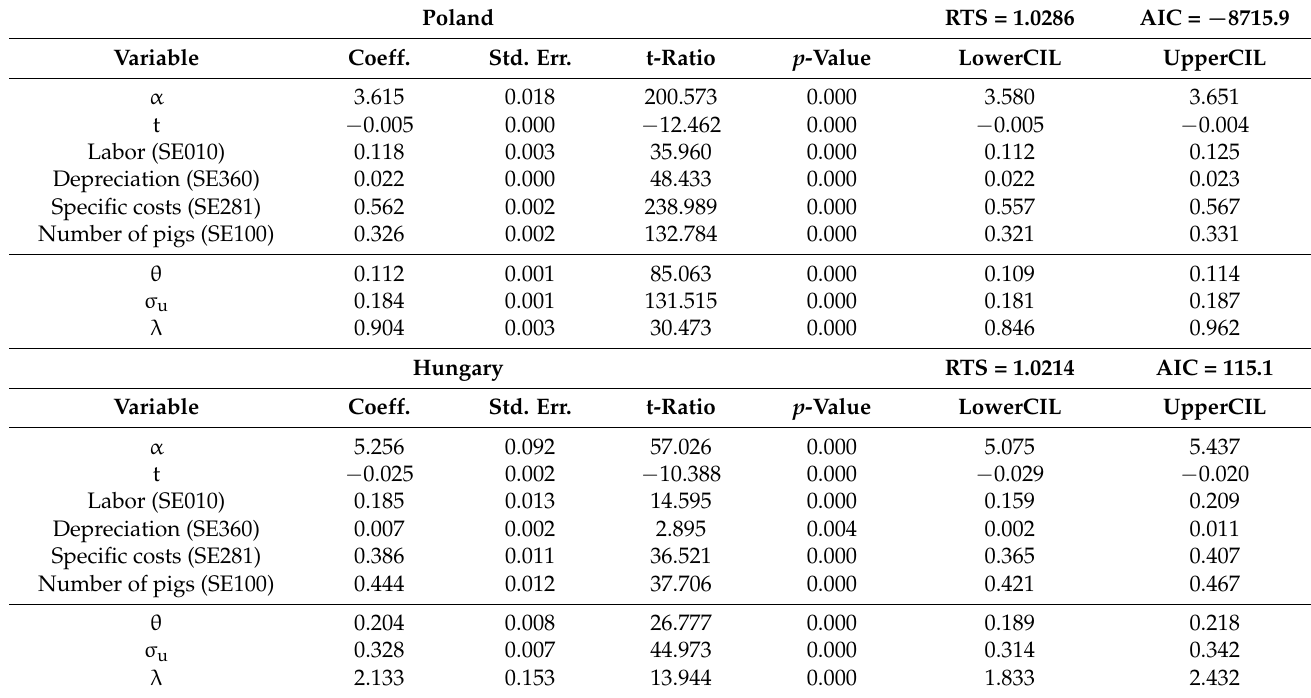
Table 3. Parameter estimates for the Cobb–Douglas function and the “true” random effects